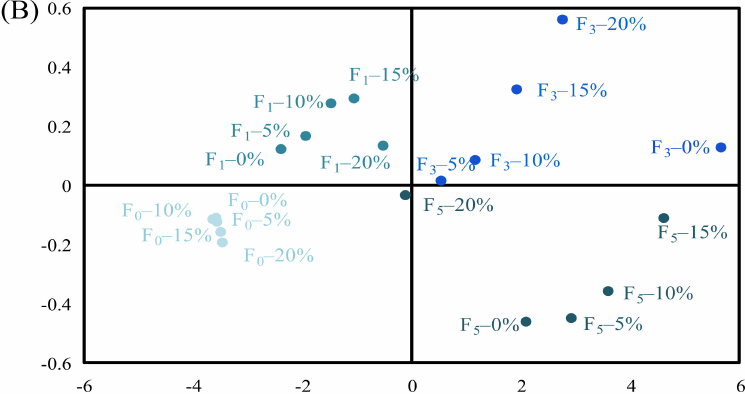
Figure 5. Principal component analysis (PCA) of the indicators and patties at different F–T cycles. Weighed PCA biplot of ( A ) factor loading plot and ( B ) factor scores plot for the first two principal components, accounting for approximately 99.32% of the total variance of the data. PC1 describes 98.54% of the variation, and PC2 explains 0.78%.